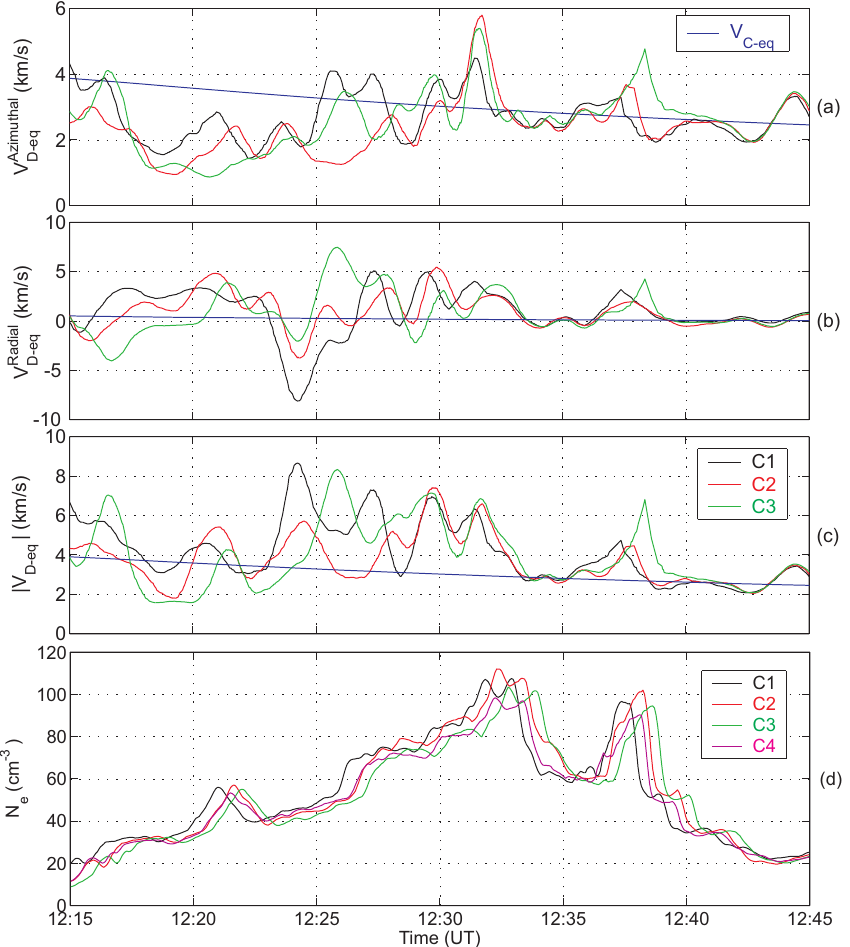
Fig. 11. Different quantities plotted as a function of time during the inbound plume crossing of 2 June 2002: (a)–(c) electron drift velocity V D − eq measured by EDI onboard C1, C2 and C3 and projected onto the magnetic equatorial plane; (d) electron density determined from WHISPER onboard the four CLUSTER spacecraft (similar as panels (a)–(d) of Fig.